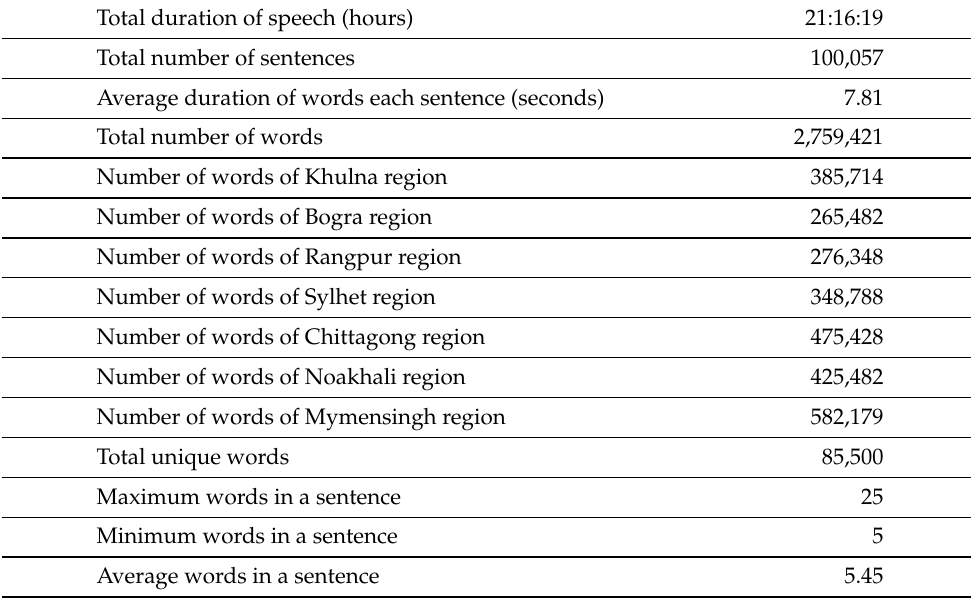
Table 1. Summary of Bangla Speech Data.